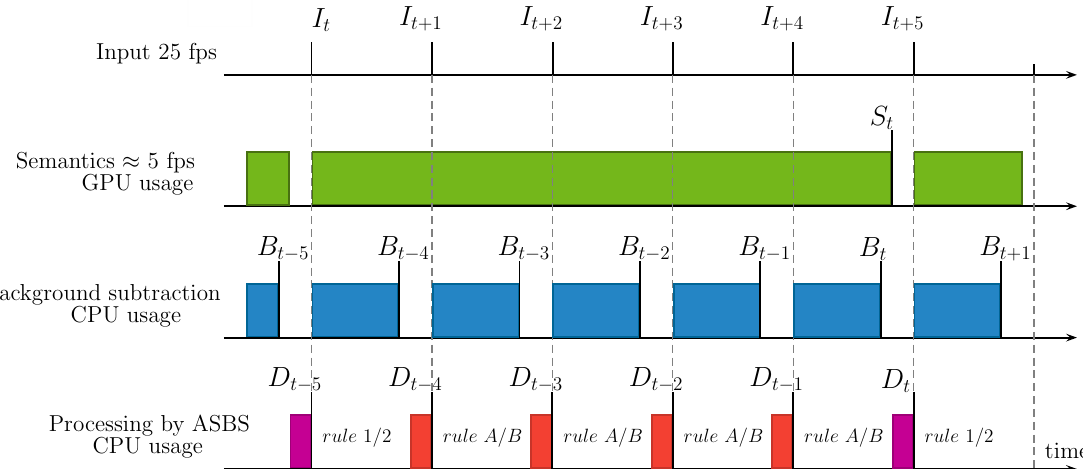
Figure 3. Timing diagram of ASBS in the case of a real-time BGS algorithm ( ∆ B < δ I ) satisfying the condition ∆ B + ∆ D < δ I . Note that the output stream is delayed by a constant ∆ S + ∆ D time with respect to the input